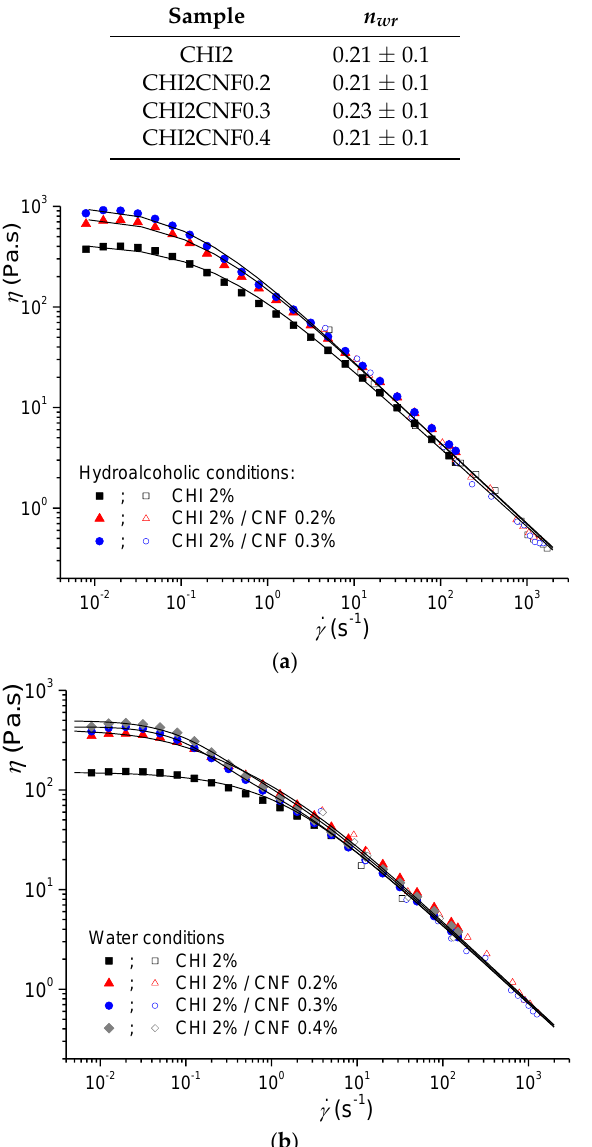
Table 1. Flow exponent index n wr values of CHI solution and CHI/CNF suspensions in aqueous conditions (CHI concentration: 2% ( w / w )).